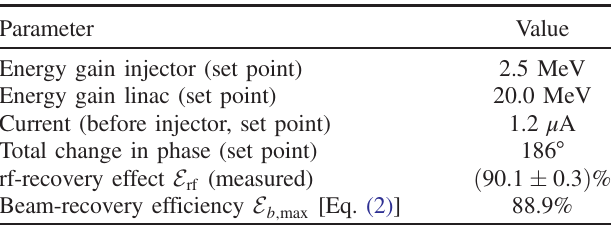
TABLE I. Main parameters of the once-recirculating ERL operation.